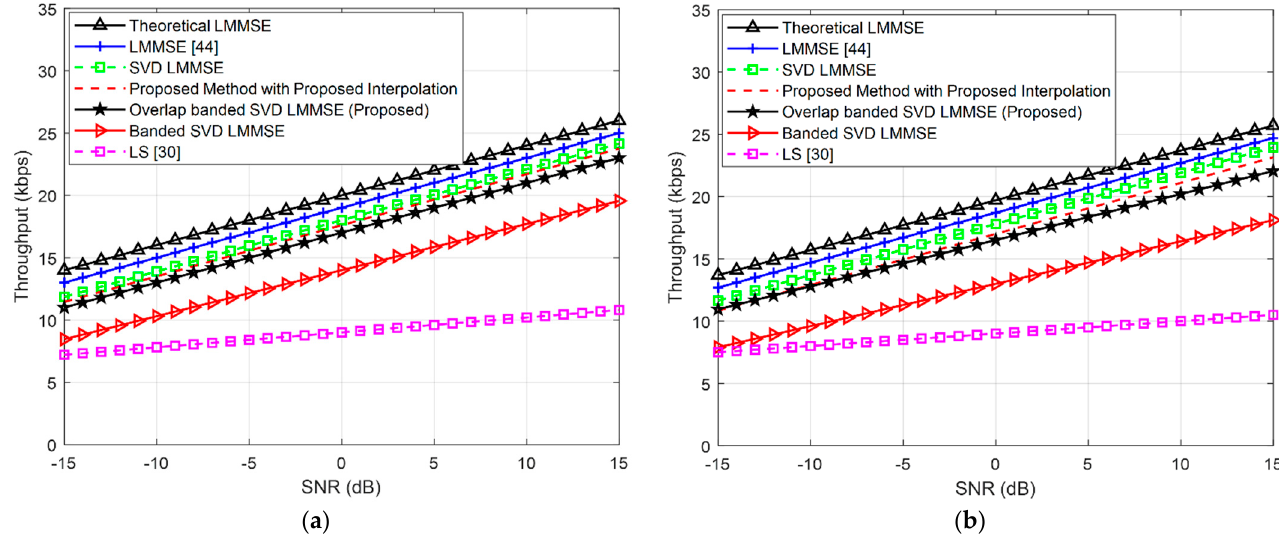
Table 5. Received SNR (dB) at BER = 2 10 − for different channel estimators.